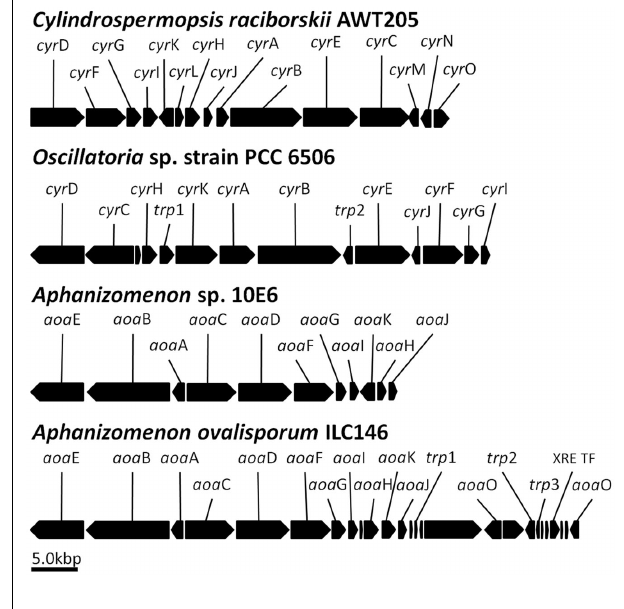
FIGURE 2 |The aoa/cyr clusters putatively involved in cylindrospermopsin biosynthesis in four cyanobacterial species. The scheme was constructed based on data for Cylindrospermopsis raciborskii (Mihali et al., 2008), Oscillatoria sp. PCC 6506C (Mazmouz et al., 2010), Aphanizomenon strain 10E6 (Accession Number,WOS, 000281239600017; Stuken and Jakobsen, 2010), and Aphanizomenon ovalisporum strain ILC146 (draft, yet unpublished sequence). Open reading frames without designation represent hypothetical proteins. Note the transposase (trp) genes and transcription factor (XRETF) in the sequence of Aphanizomenon strain ILC146.The high sequence similarity between genes in the four species suggests a common ancestor but the significant differences in gene organization may indicate lateral gene transfers and transposases involvement (see text). Note that despite the presence of genes essential for CYN biosynthesis, we are still missing experimental evidence for the role of this